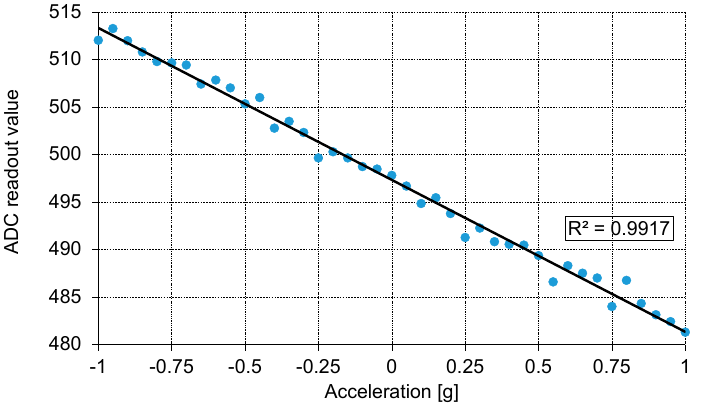
Figure 18. The output of the ROIC of the Y-axis sensor as a function of gravitational acceleration.